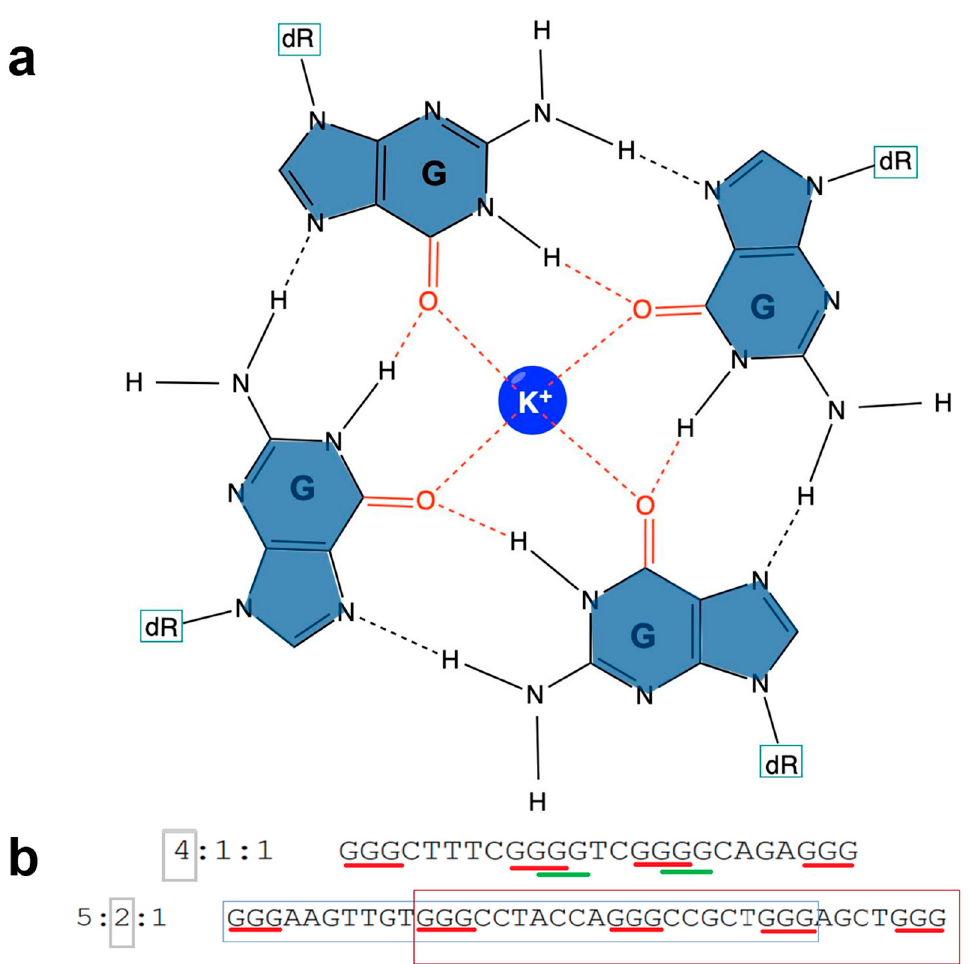
Figure 1. G-quadruplex structure. ( a ) G-tetrad structure that forms G-quadruplexes. Hydrogen bonds between the guanine from different tetrads form a planar ring. ( b ) Sequence of G4 with multiple guanine tetrads. Here, 4:1:1 and 5:2:1 refer to the result from Quadparser separated out as the number of tetrads: total G4 sequences: non-overlapping G4 sequences. Red line: first occurrence of G4 forming sequence; green line: alternative G4 forming sequence.